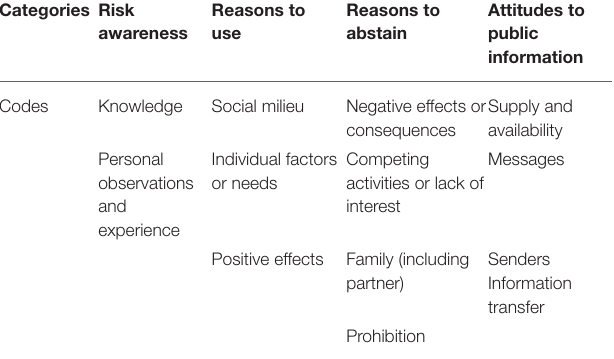
TABLE 3 | Final coding scheme. Categories Risk Reasons to awareness